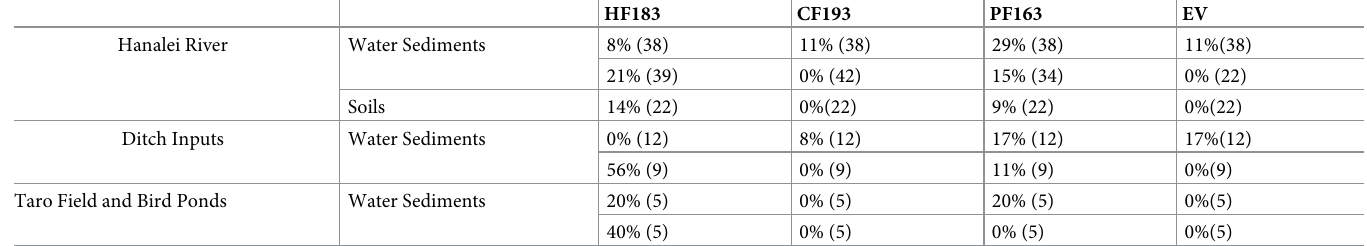
Table 4. Occurrence of Bacteroidales host-specific fecal markers and enteroviruses in Hanalei river and potential source water, sediments and soils. Total n are shown in parentheses.